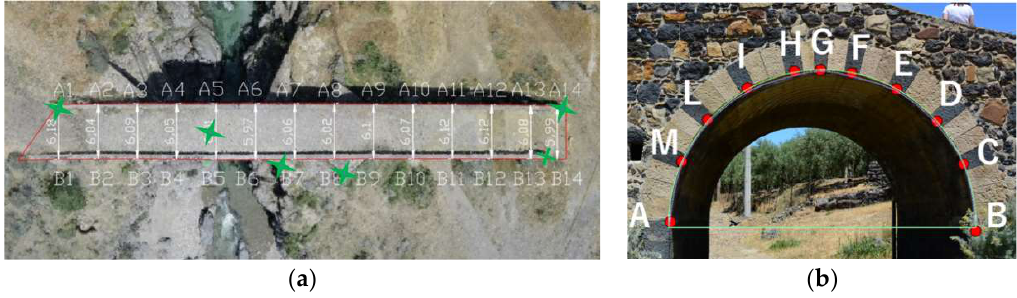
Figure 12. ( a ) 29 keypoints on the pounding upper surface; ( b ) 11 keypoints on the south side of the north-east arch. north-east